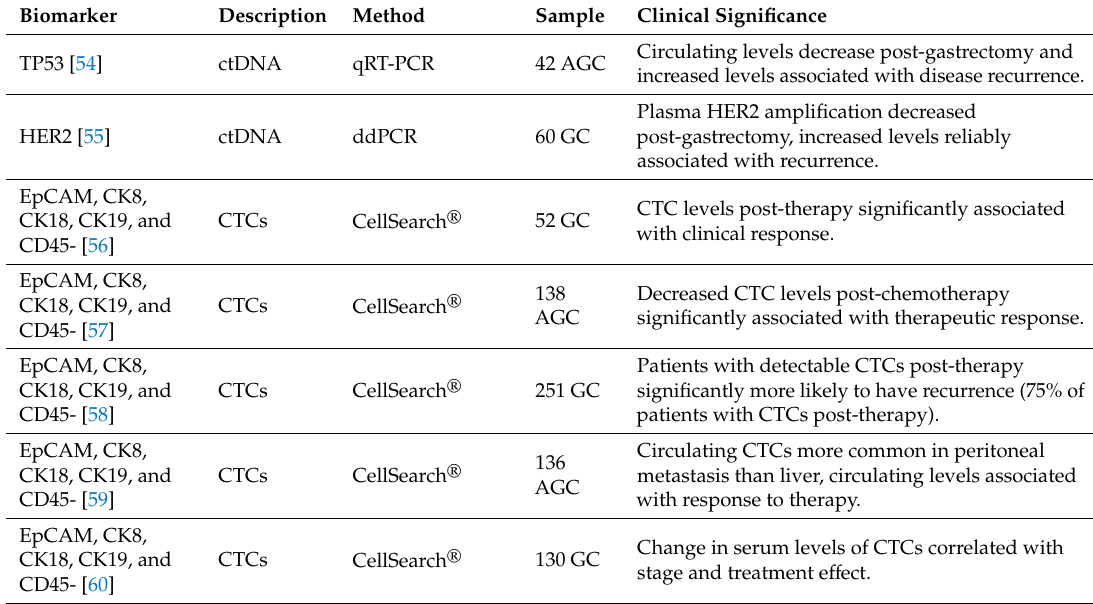
Table 4. Liquid biopsy for therapeutic monitoring in gastric cancer